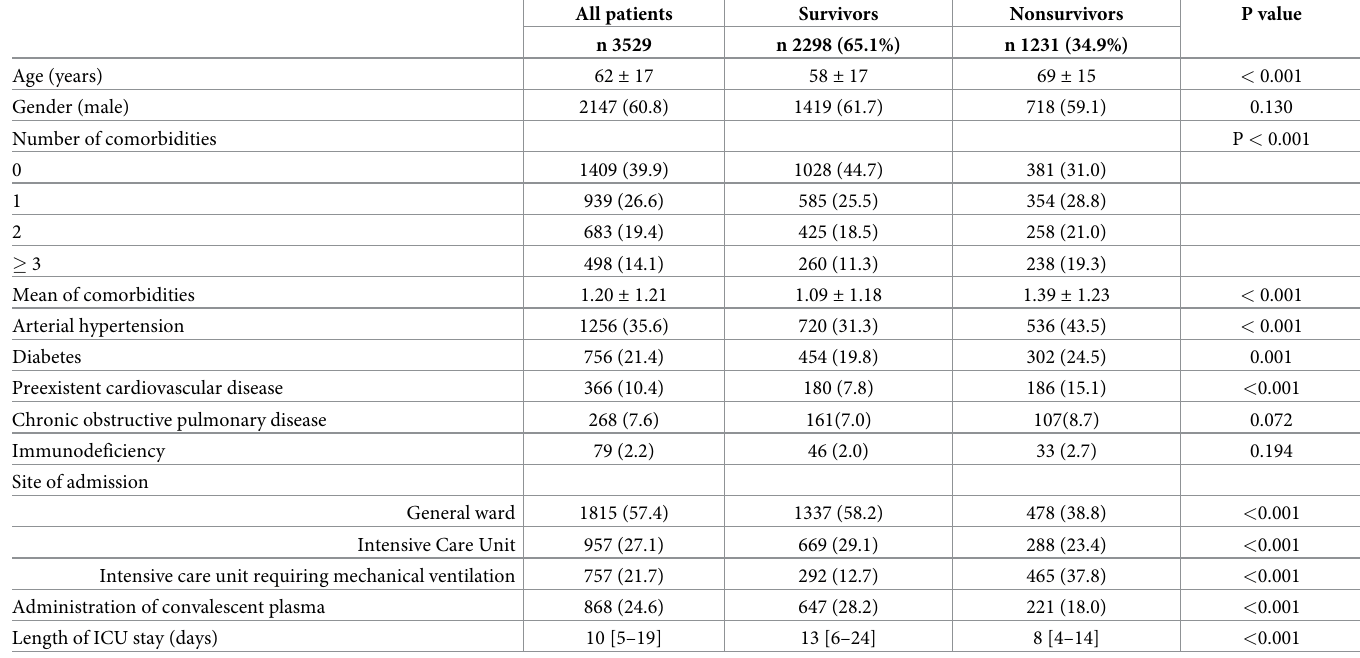
Table 1. Characteristics of the entire group, and comparison between survivors and nonsurvivors.